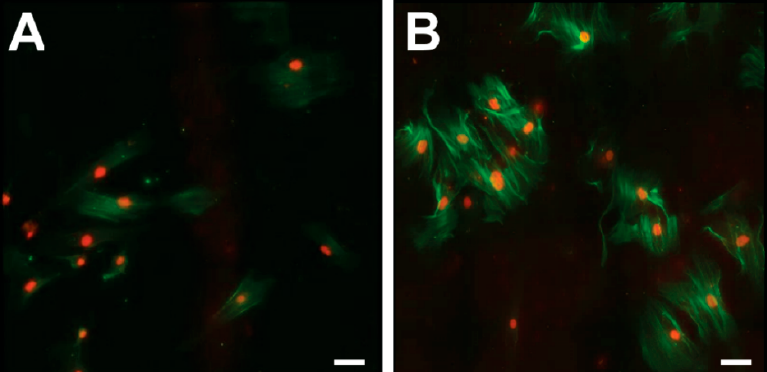
Figure 7. Immunofluorescence for α -SMA (green) in CoReFs treated without ( A ) or with 1 ng/mL TGF- β 1 ( B ) for 4 days. Scale bars, 20 µm.